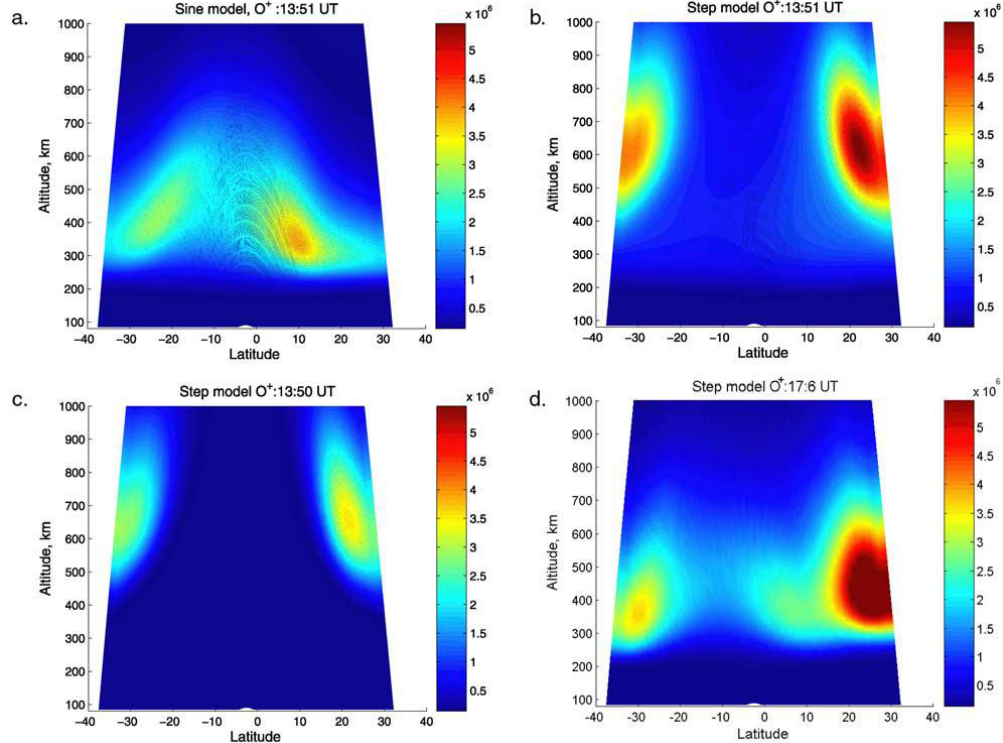
Fig. 2. Oxygen ion features of the 30 October 2003 magnetic storm modeled by SAMI2. The top-left panel shows the quiet time ionosphere, the top-right the ionosphere after the storm-time electric field has been applied for ∼ 2h, the bottom-left with the electric field on for ∼ 2h